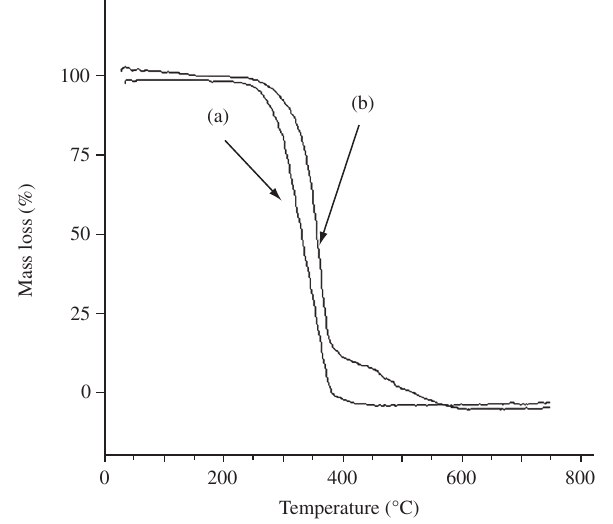
Figure 3. XRD of samples: a) lyophilized CyA, b) lyophilized PLGA 75:25 and c) lyophilized mixture.